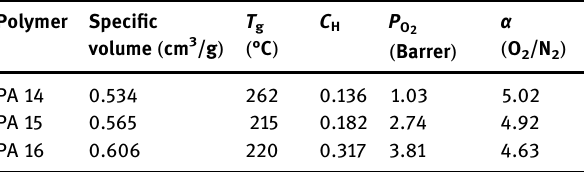
high gas permeable HFA/TERT block and barrier DBF/ISO block ( Figure 8 ) with a di ff erent block length of 9:9, 12:12, and 18:18 repeating units on each block ( 67 ) .